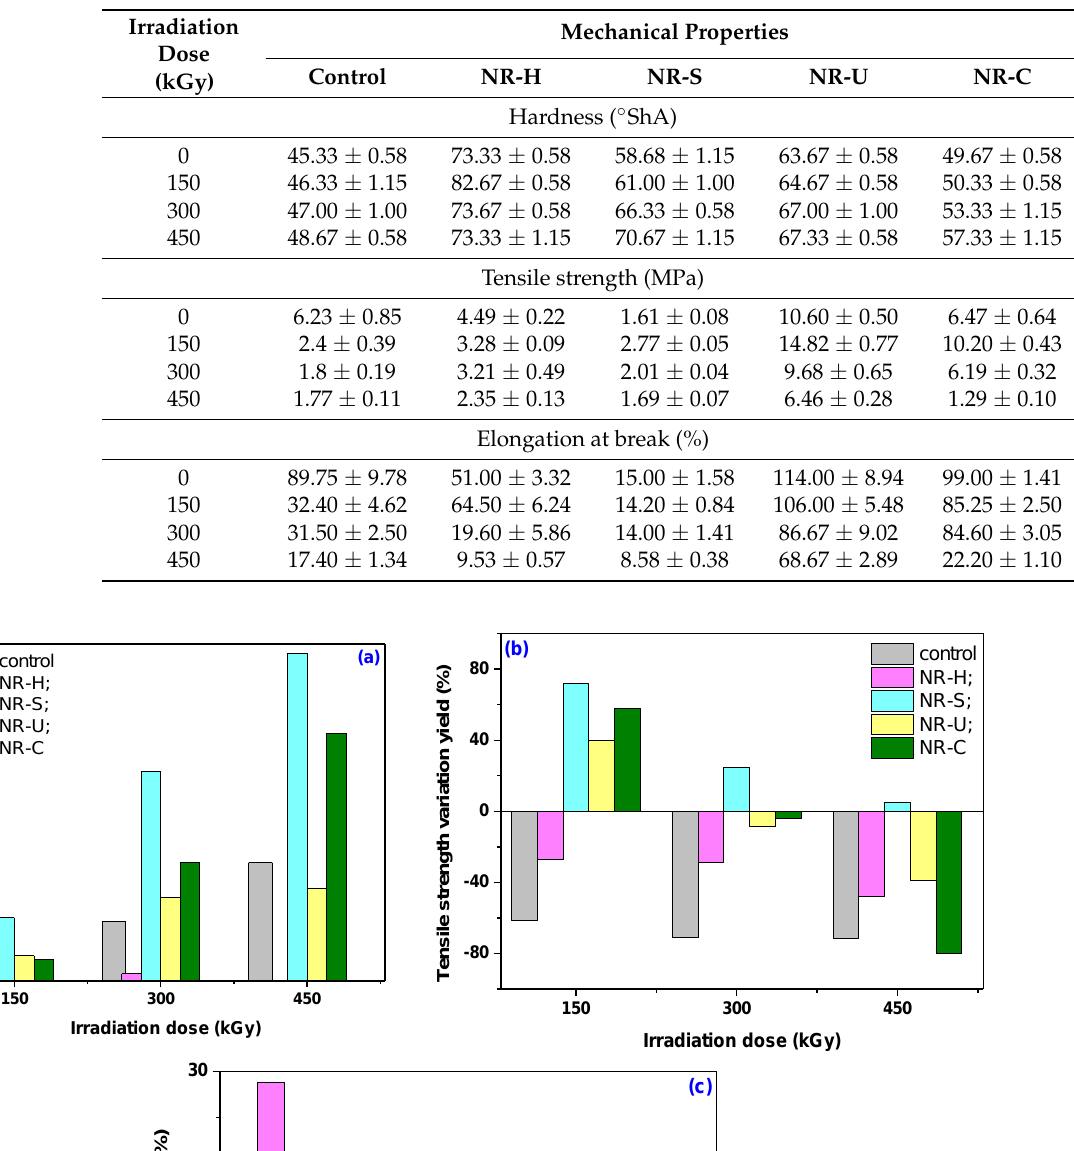
Table 3. The mechanical properties variation as a function of irradiation dose and filler type.